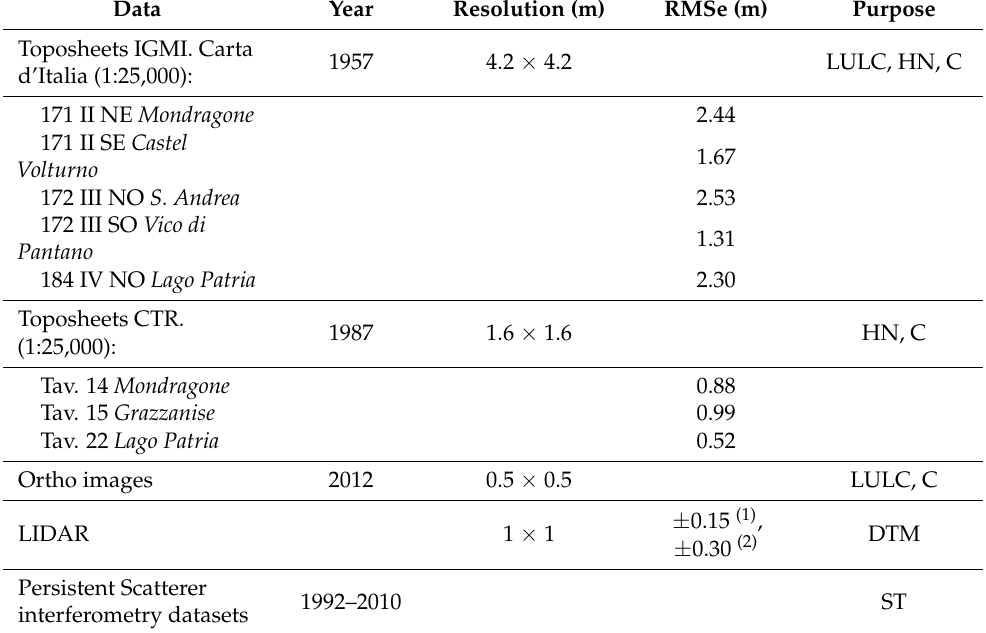
Table 1. Input data used to obtain land use and land cover (LULC), hydrographic network (HN), coastline (C), subsidence trends (ST), and digital terrain model (DTM). The year of data acquisition, its resolution and root mean square error (RMSe) are also reported. Data Year Resolution (m) RMSe (m)